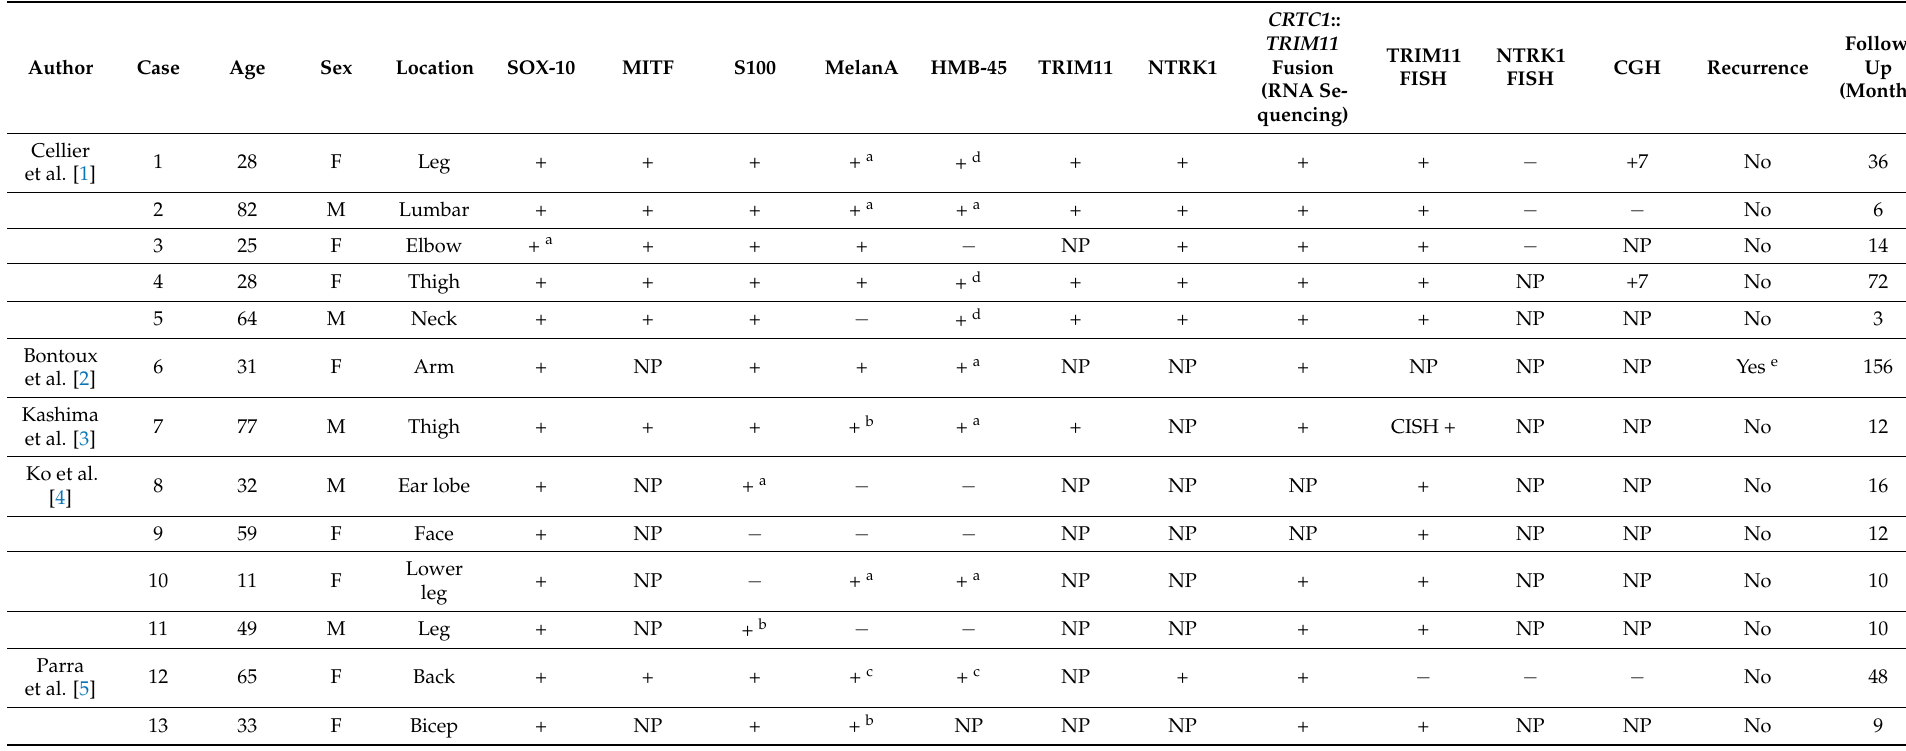
Table 1. Clinical, histopathologic, immunohistochemical and molecular characteristics of all published CMTCT